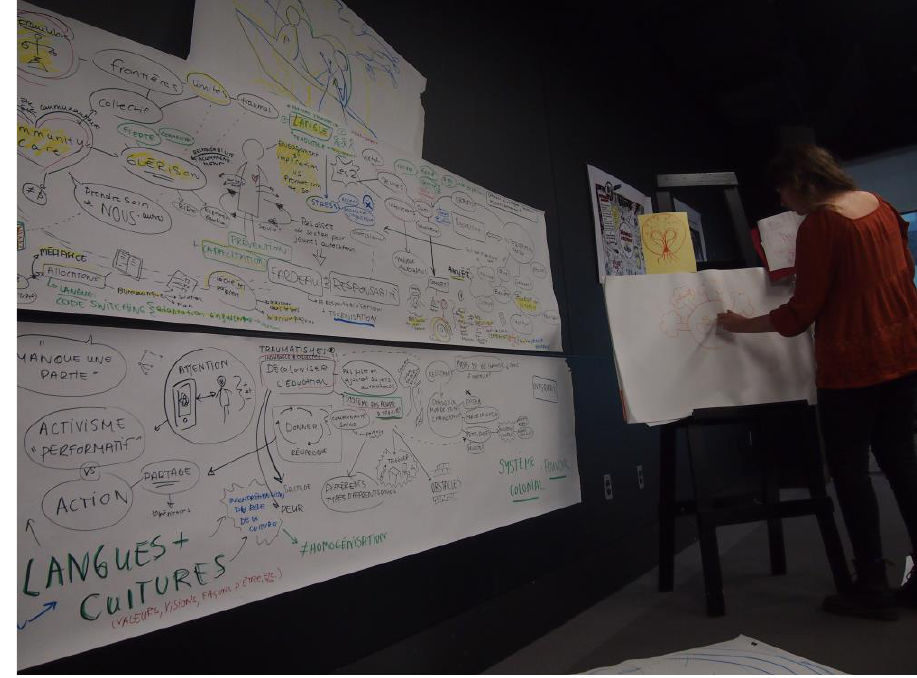
Figure 1. Brainstorm process in creating postcard.